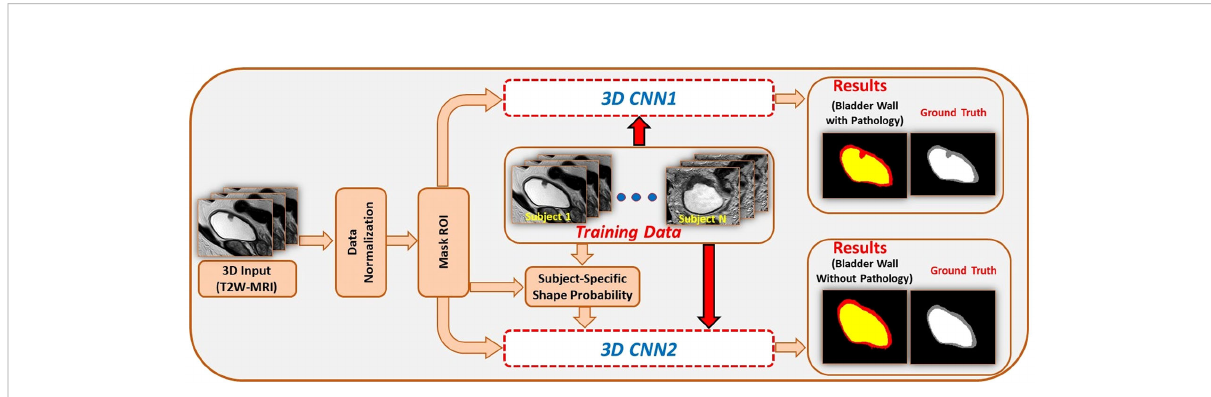
FIGURE 3 An example for bladder cancer image segmentation using deep learning. Image from Ref (16). Copyright © 2020, IEEE.